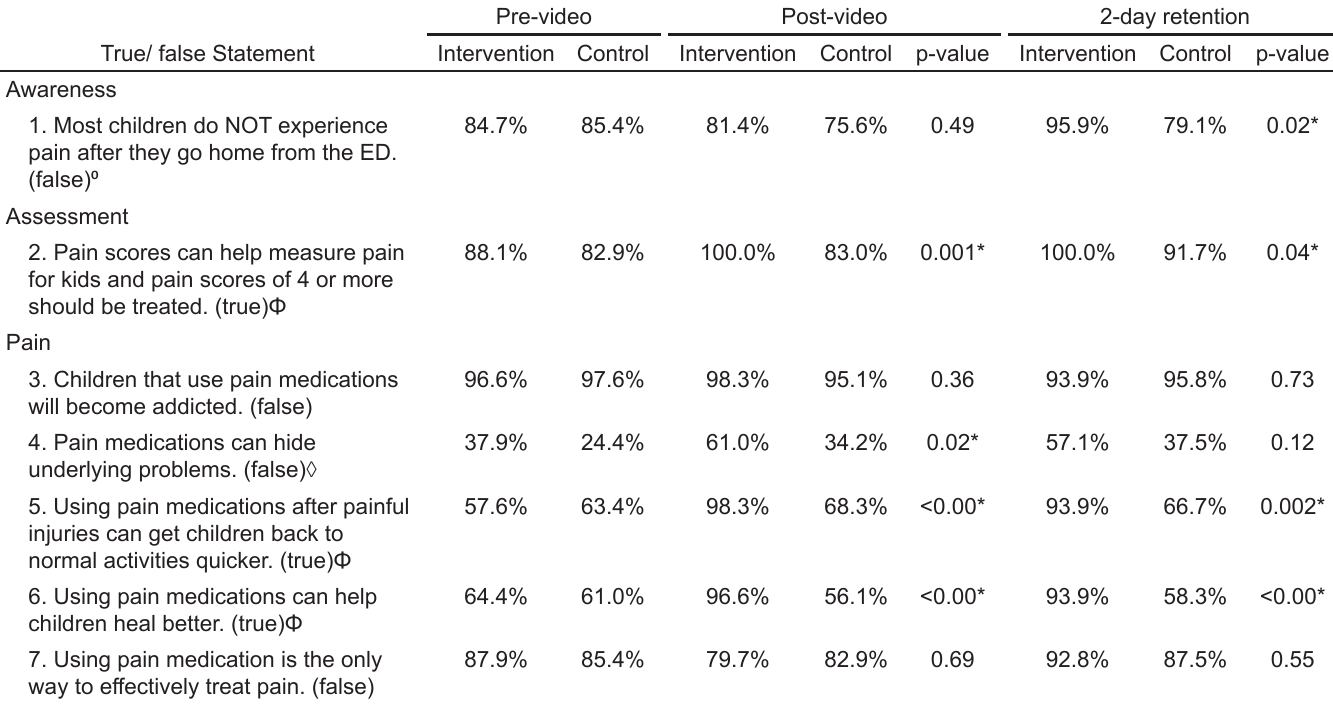
Table 3. Parent knowledge